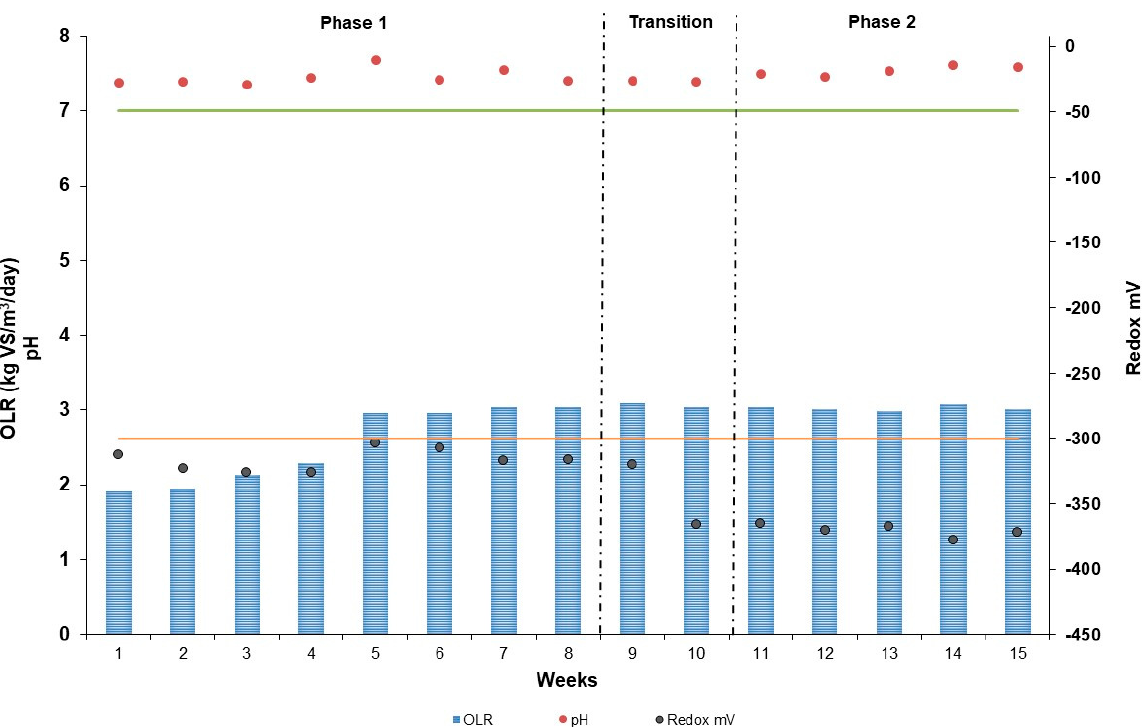
Figure 4. Organic loading rate (OLR), pH, and potential redox of the pilot scale reactor during the various running phases.